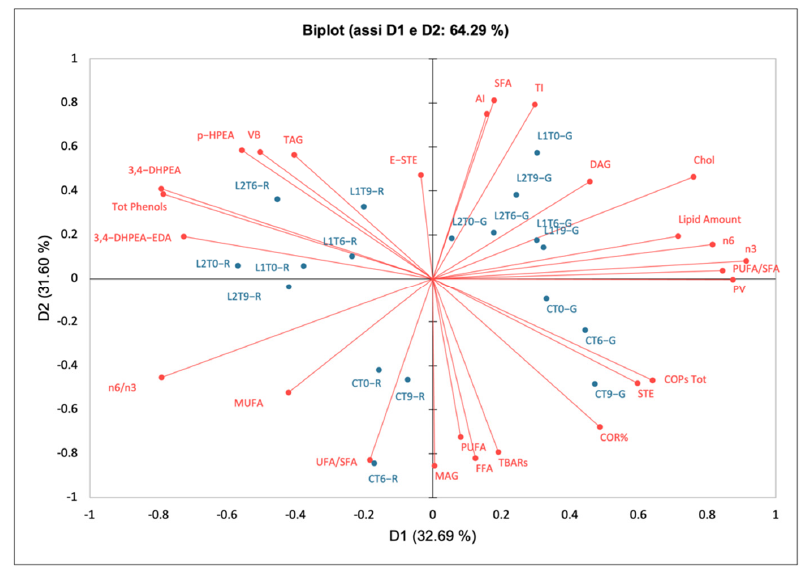
Figure 1. Biplot of raw and grilled hamburgers. 3,4-DHPEA, Hydroxytyrosol; 3,4-DHPEA-EDA, decarboxymethyl oleuropein aglycone; AI, Atherogenic Index; COPs, cholesterol oxidation products; COR, cholesterol oxidation ratio; DAG, diacylglycerols; E-STE, esterified sterols; FFA, free fatty acids; MAG, monoacylglycerols; MUFA, monounsaturated fatty acids; p -HPEA, tyrosol; PV, peroxide value; PUFA, polyunsaturated fatty acids; SFA, saturated fatty acids; STE, sterols; TAG, triacylglycerols; TBARs, thiobarbituric acid reactive substances; TI, thrombogenic index; UFA, unsaturated fatty acids; VB, verbascoside.